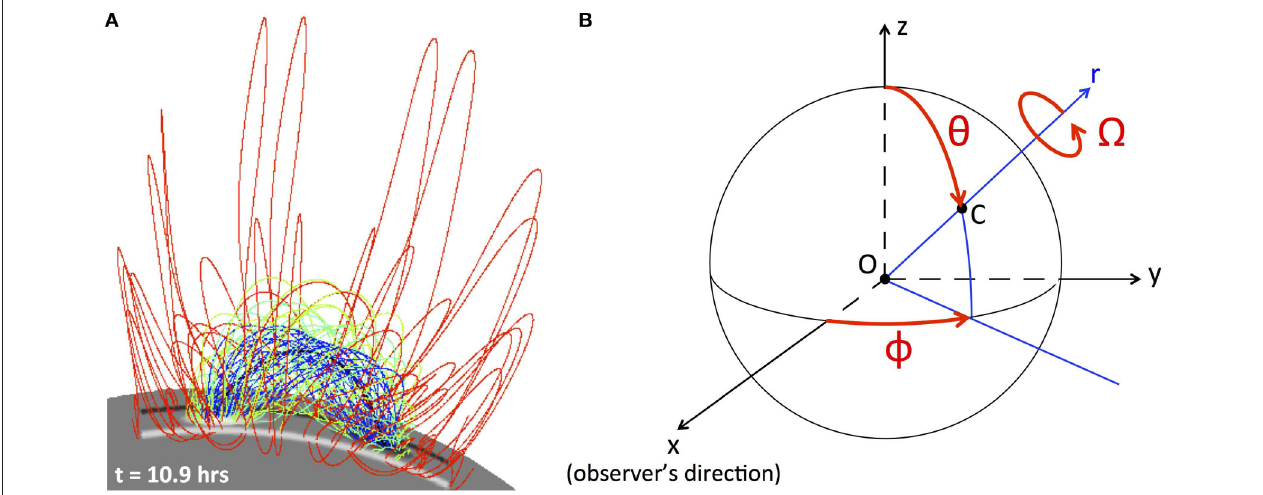
FIGURE 2 | (A) 3D view of the magnetic field of our synthetic test bed. The gray color scale display the photospheric magnetic flux (black/white for negative/positive magnetic flux). The green and blue lines show the magnetic field lines of the twisted flux rope. The red lines correspond to the magnetic field lines of the embedding magnetic field. (B) Schematic of the three parameters considered for our first study. The black thin solid lines highlight the solar photosphere. ( θ,φ ) correspond to the angular coordinates of C , the photospheric center of the 3D box containing the magnetic field of our test bed, while (cid:127) is the rotation angle of that 3D box around the solar radial direction passing by